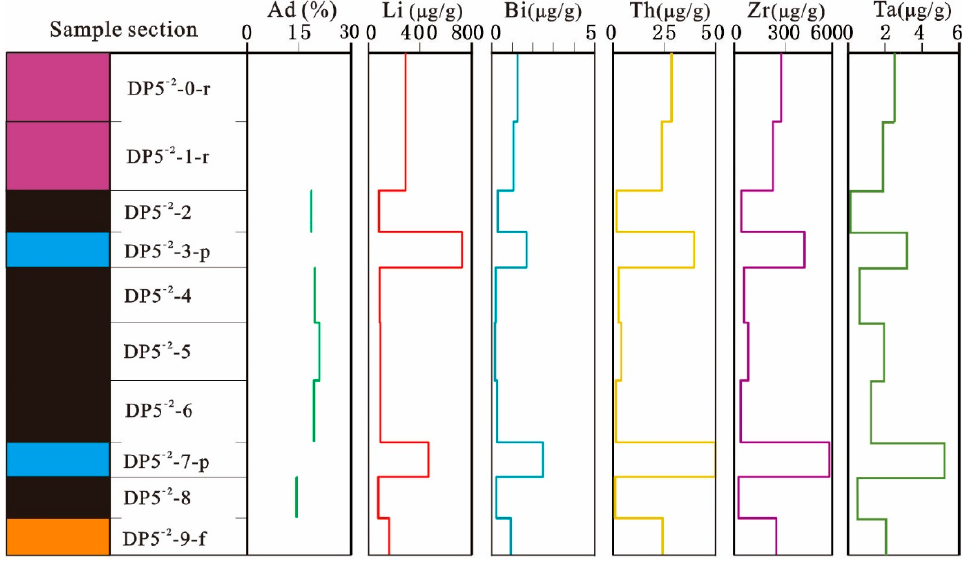
Figure 14. Variations in the ash yield, Li, Bi, Th, Zr, and Ta throughout the coal seam in Dongpo Mine.